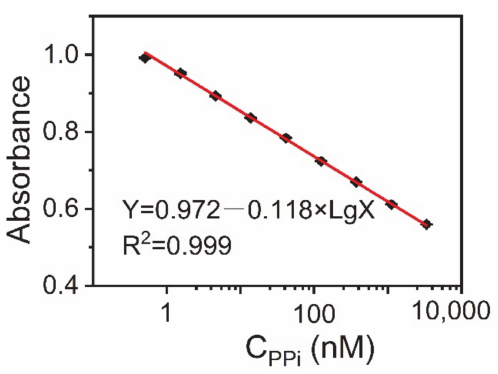
Figure 5. Calibration curve between the absorbance at 452 nm against the logarithmic concentration of PPi in artificial urine samples. Reaction conditions: AuNCs-Cu 2+ , 0.25 mg · mL − 1 ; TMB, 0.1 mg · mL − 1 ; and H 2 O 2 , 100 µ M. The error bars represent the standard deviation of three